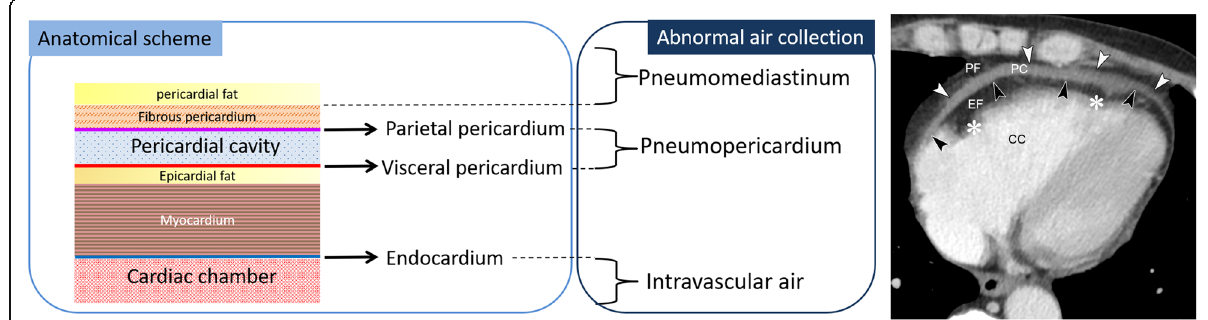
Fig. 12 Anatomy of the pericardium and related diseases of abnormal air collection at each anatomical space. Axial chest CT of a 47-year-old man with chronic kidney disease shows fluid collection in the pericardial cavity. The CT shows the pericardial fat (PF), parietal pericardium (white arrowheads), pericardial cavity (PC), visceral pericardium (i.e., epicardium) (black arrowheads), epicardial fat (EF), myocardium (white asterisks), and cardiac chamber (CC)